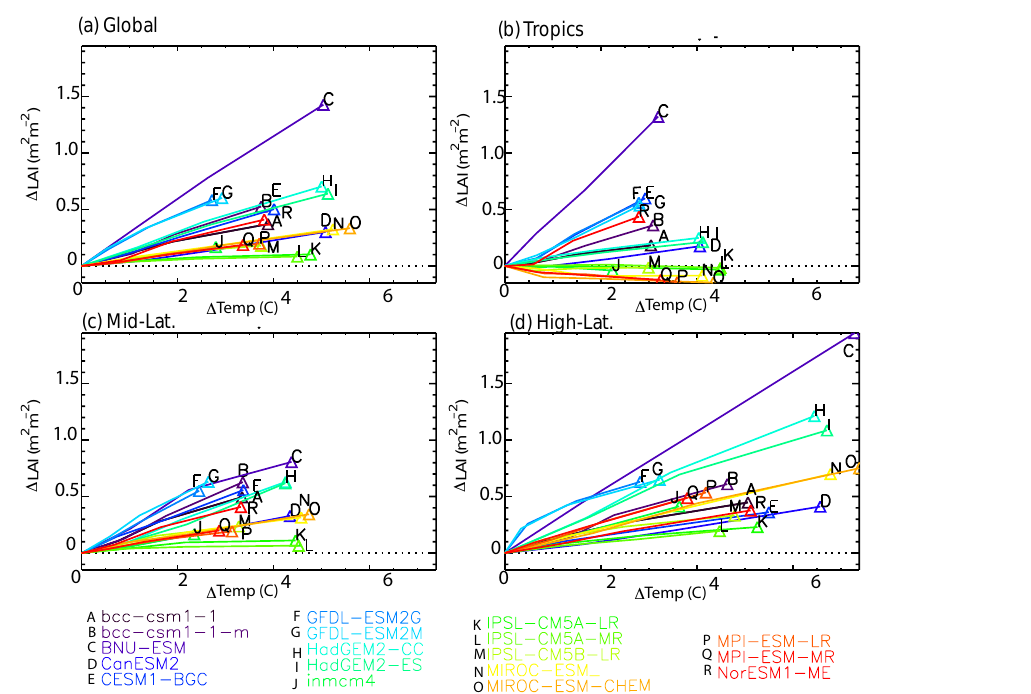
Figure 3. Scatter plot of the change in annual average surface temperature ( T s , C) ( x axis) against the change in annual average LAI (m 2 m − 2 ) ( y axis) for the global (a) , tropics (b) , mid-latitudes (c) and high latitudes (d) . Averages over four time periods are shown: 1981– 2000 (with 0 changes), 2011–2030, 2041–2060 and 2081–2100, connected by a line. The final point (2081–2100) for RCP8.5 is a triangle. The temperatures increase in all simulations with time, so increases in the x axis indicate an increase in time. Note that there are four points along each line, and thus if there is no inflection point, the slope of the line is constant across the 21st century. A similar plot including RCP4.5 is included in Fig.